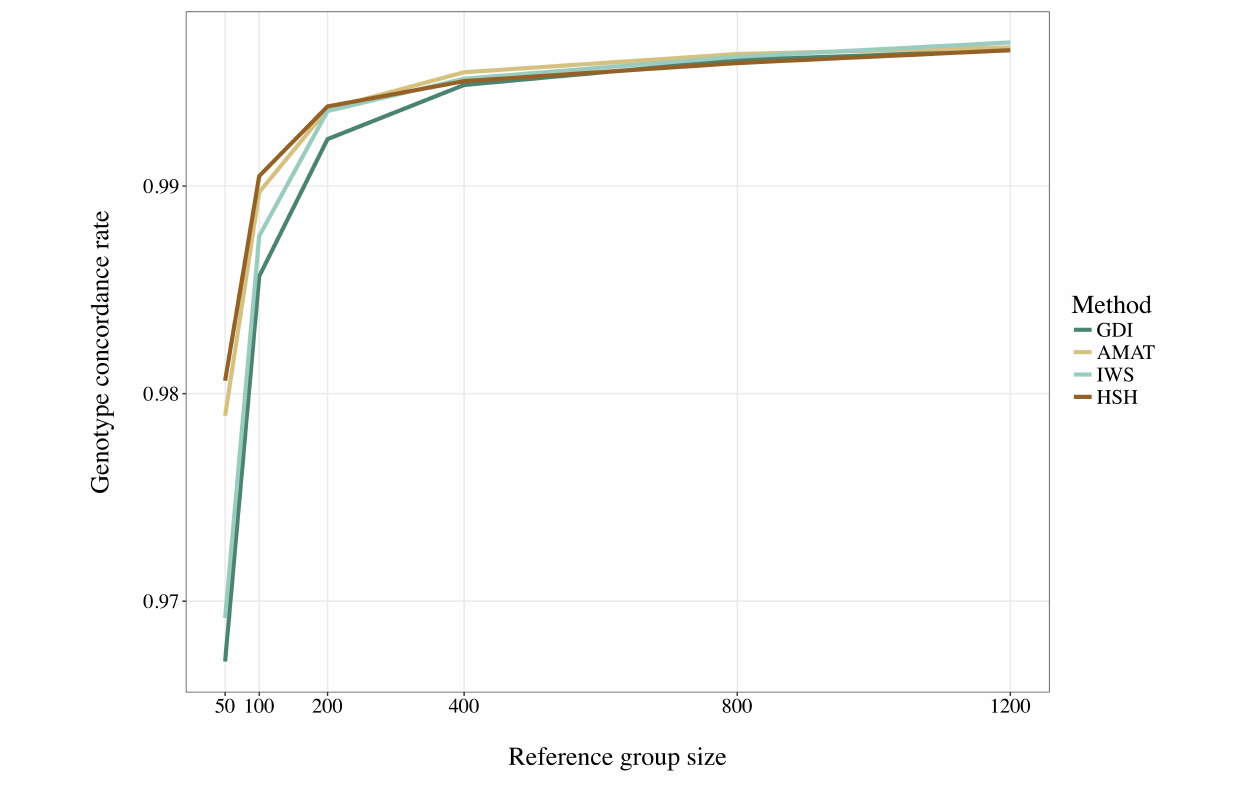
FIGURE 10 | Genotype concordance rates for all SNP using reference population sizes from 50 to 1,200 individuals. The methods compared are the key ancestors (AMAT), the Highly Segregating Haplotype selection (HSH), the Inverse Weighted Selection (IWS), and the Genetic Diversity Index (GDI). All standard errors are below